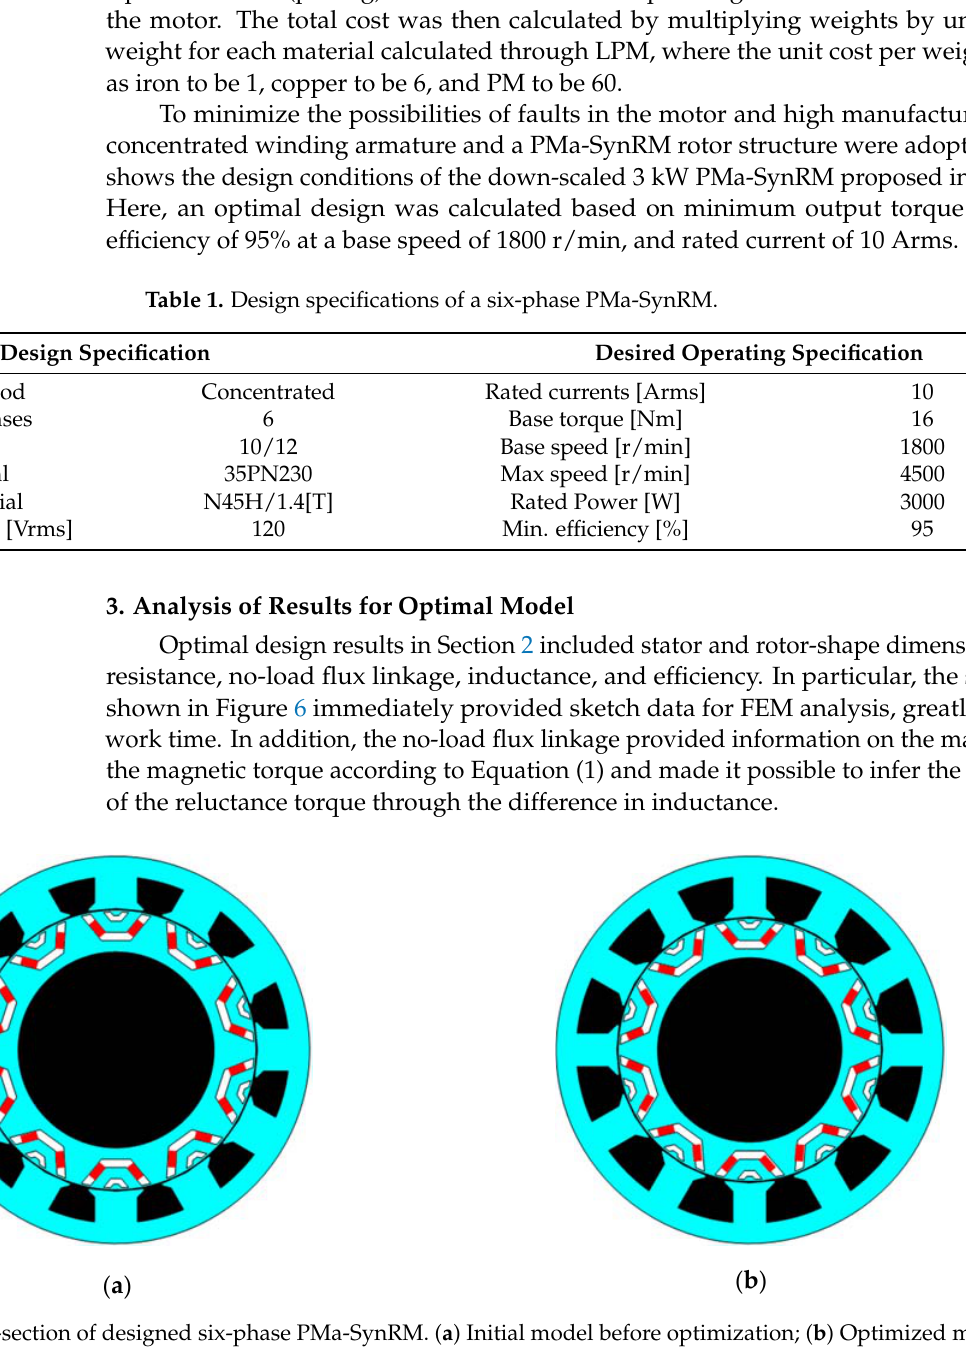
Figure 6. Cross-section of designed six-phase PMa-SynRM. ( a ) Initial model before optimization; ( b ) Optimized model.